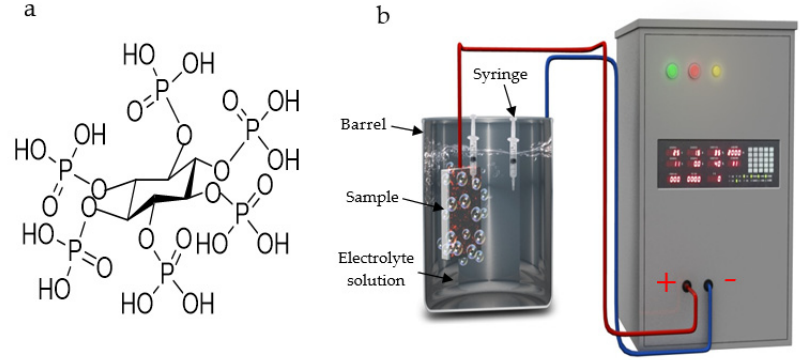
Figure 1. ( a ) H 12 Phy structure. ( b ) The schematic diagram of the MAO experiment.